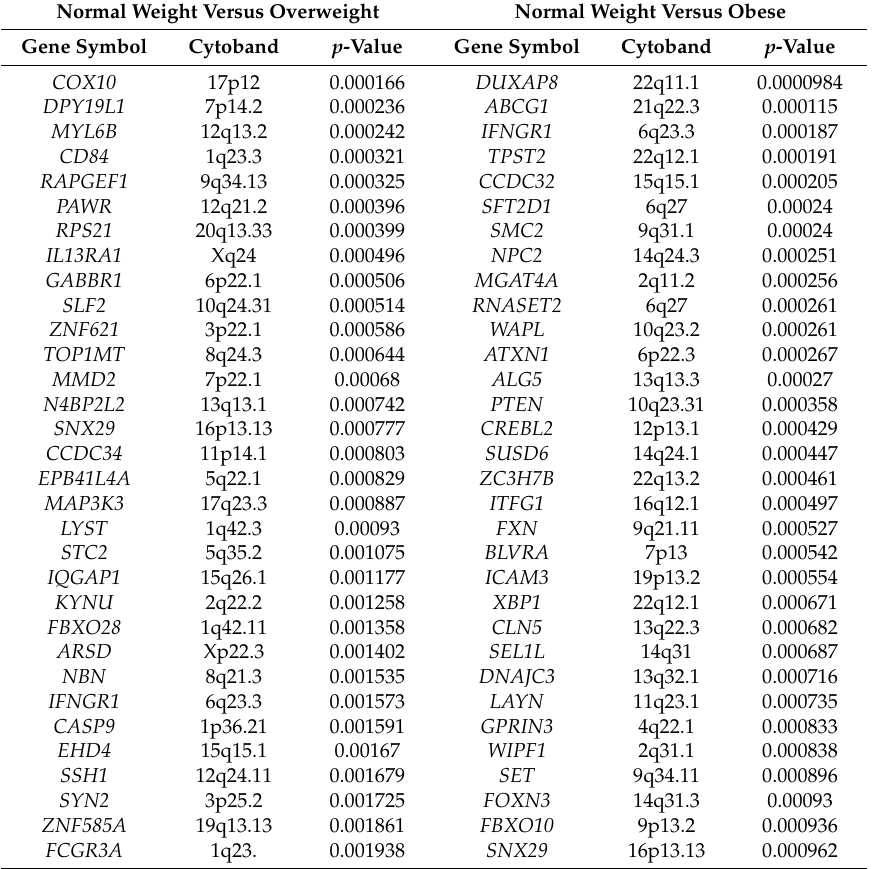
Table 1. Top 32 most highly significantly differentially expressed genes associating overweight and or obese status with triple-negative breast cancer (TNBC) in premenopausal women. Normal Weight Versus